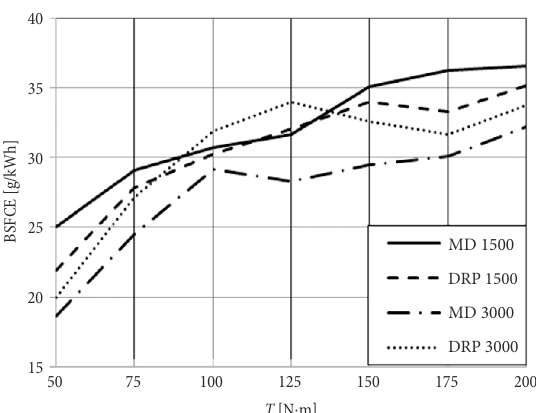
Figure 15. BSFCE vs engine load for MD and DRP at 1500 rpm and 3000